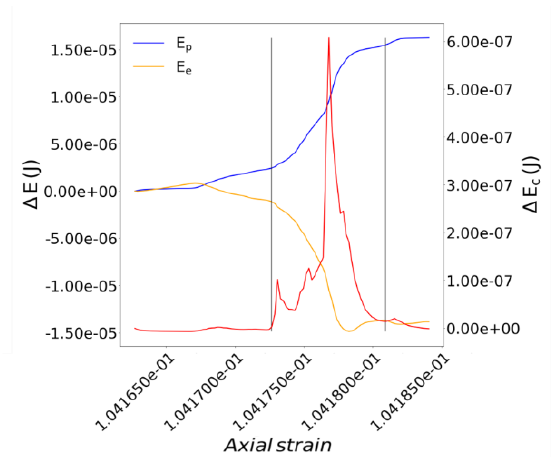
Fig. 2. Evolution of the energy dissipated through contact sliding E p , of the elastic energy E e (left y-axis), and of the kinetic energy E c (in red, right y-axis) during the burst of kinetic energy presented (the duration of the burst is materialized by the black vertical lines). Only variations of energies are plotted, the reference energy levels being taken before the burst for an axial strain of